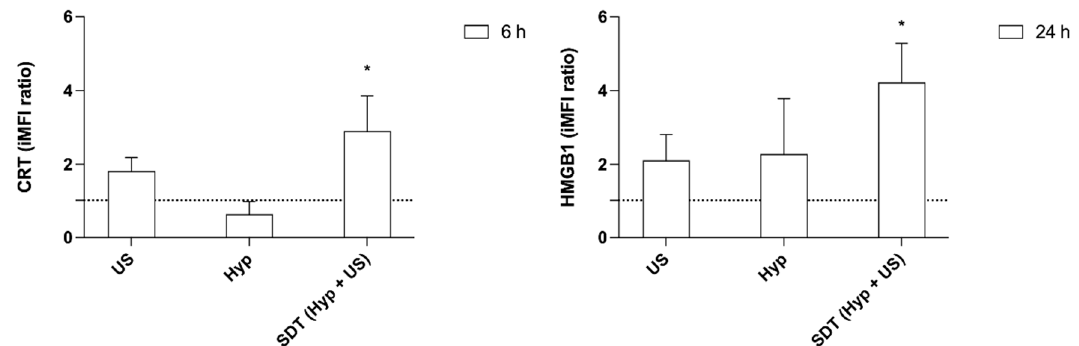
Figure 7. Evaluation of CRT and HMGB1 after hypericin-mediated sonodynamic treatment. HT-29 cells were incubated for 24 h with 0.1 µ M Hyp and then exposed to US (1.5 W/cm 2 at 1.5 MHz, continuous wave mode for 5 min). The presence of CRT and HMGB1 was evaluated 6 and 24 h after treatment, respectively. Results are expressed as iMFI ratio. Statistically significance of treated cells versus untreated cells (dashed line): * p ≤ 0.05 ( n = 3).